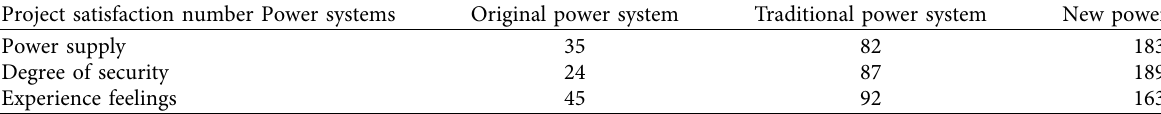
Table 1: Residents’ satisfaction with the three power systems.